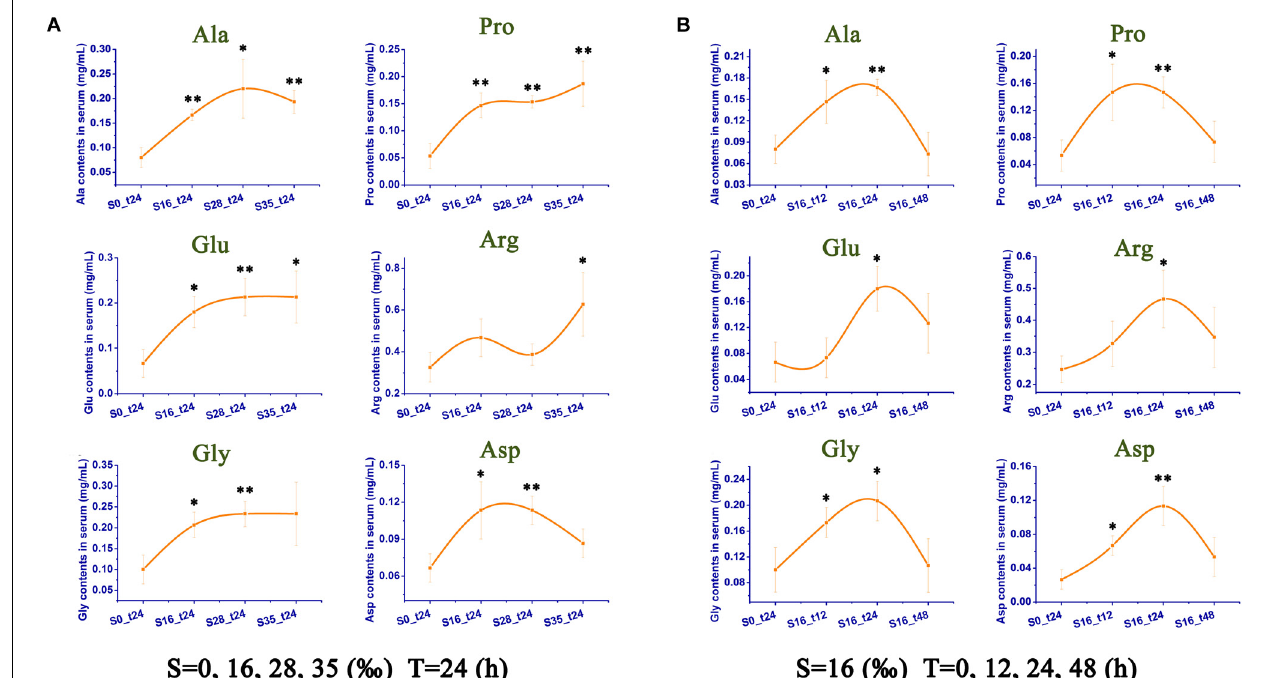
FIGURE 3 | Contents of free amino acids (FAAs) in crab serum after salinity stress. (A) Contents of FAAs in serum at 24 h after different salinities stress. (B) Contents of FAAs in serum from 12 to 48 h under one specific salinity stress (16 (cid:104)